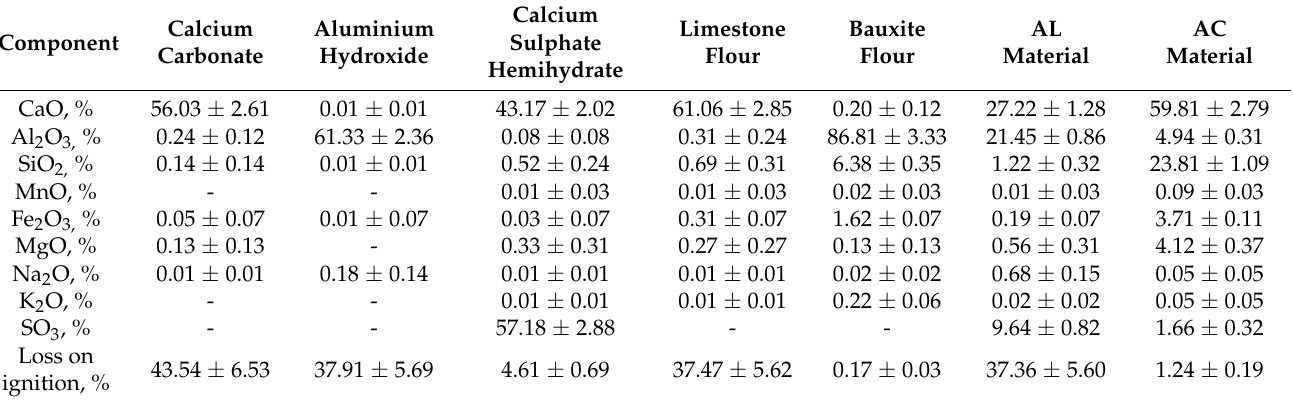
Table 2. Chemical properties of the tested